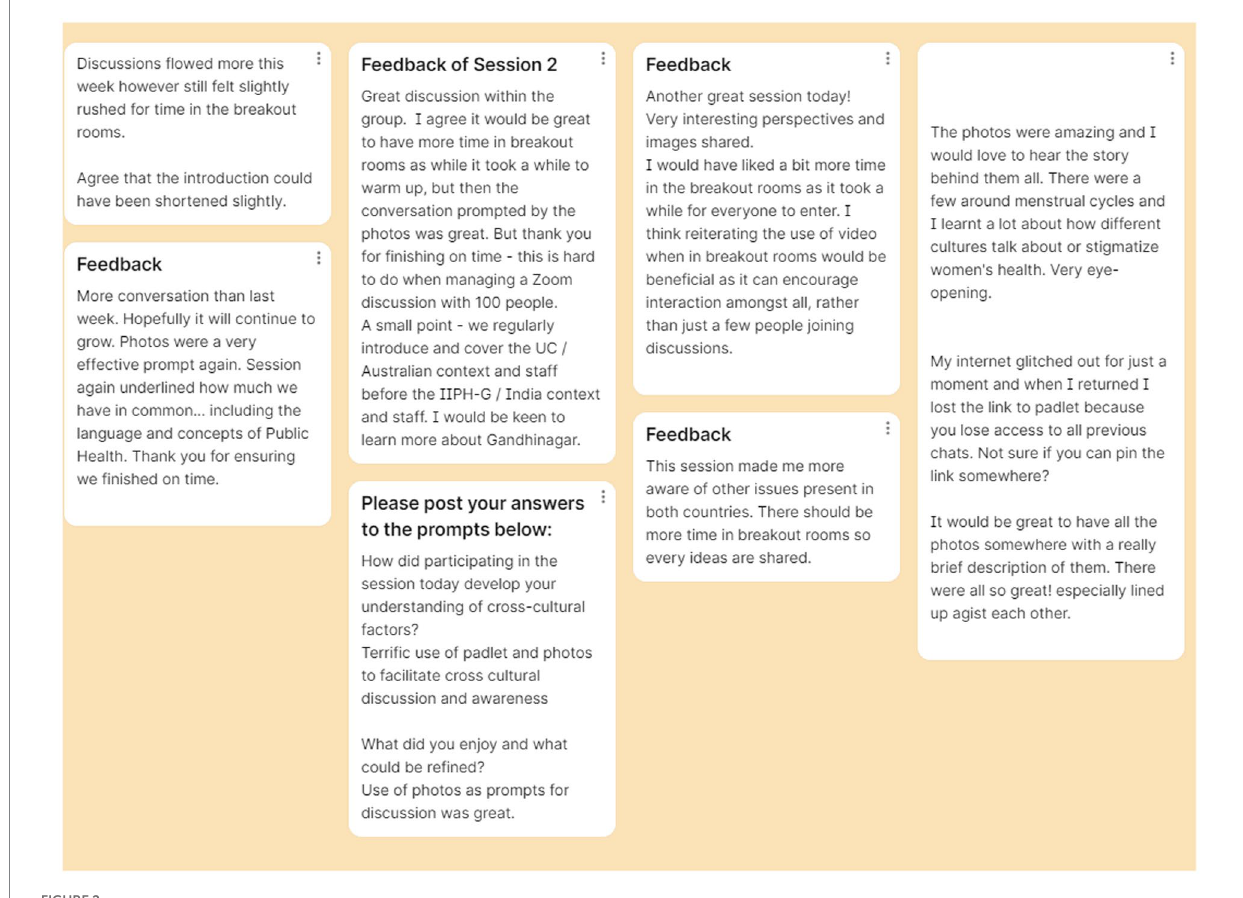
FIGURE 2 Example of post-session free text feedback provided by UC students using